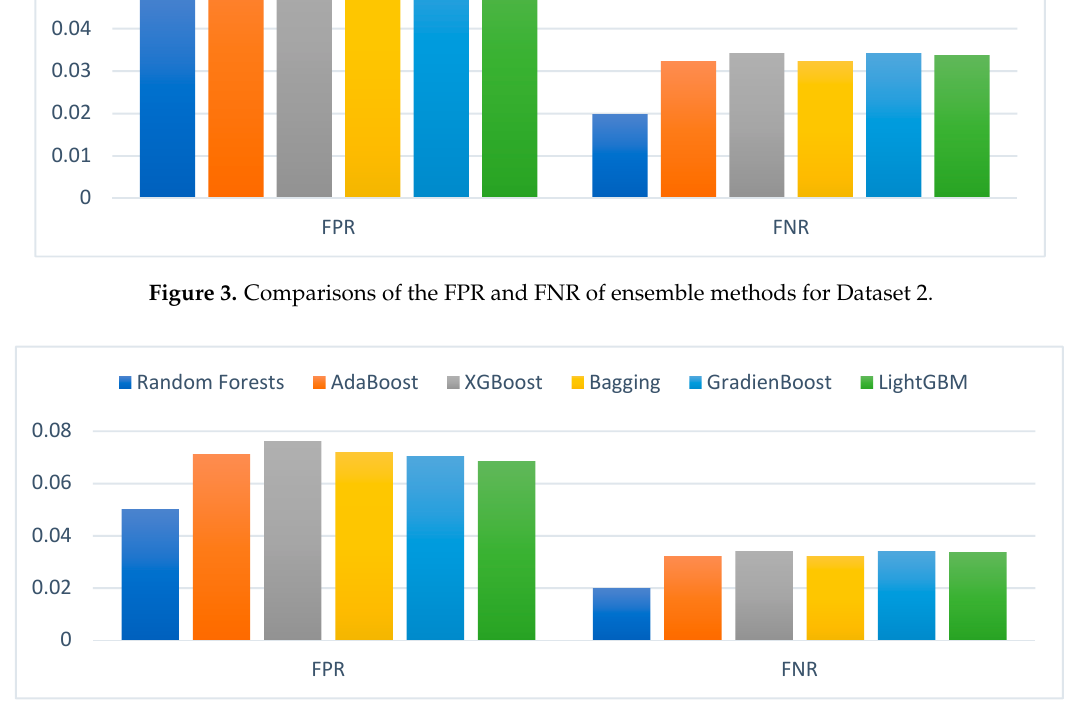
Table 4. Performance of ensemble classifiers for Dataset 3 .